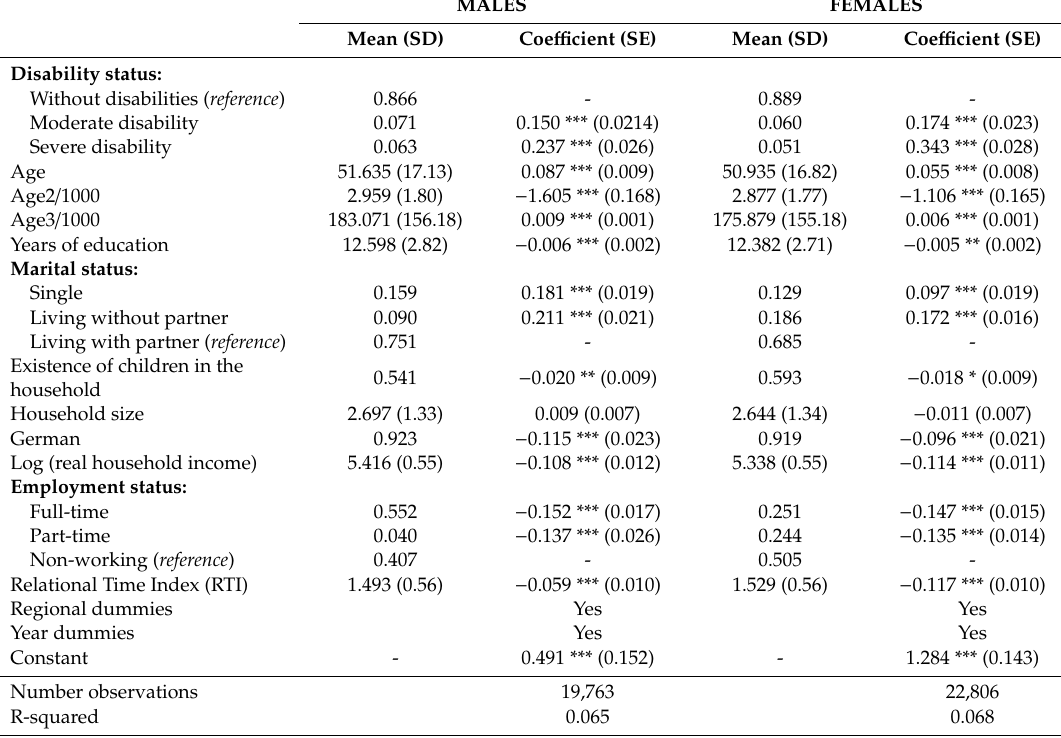
Table 1. Loneliness regressions for German males and